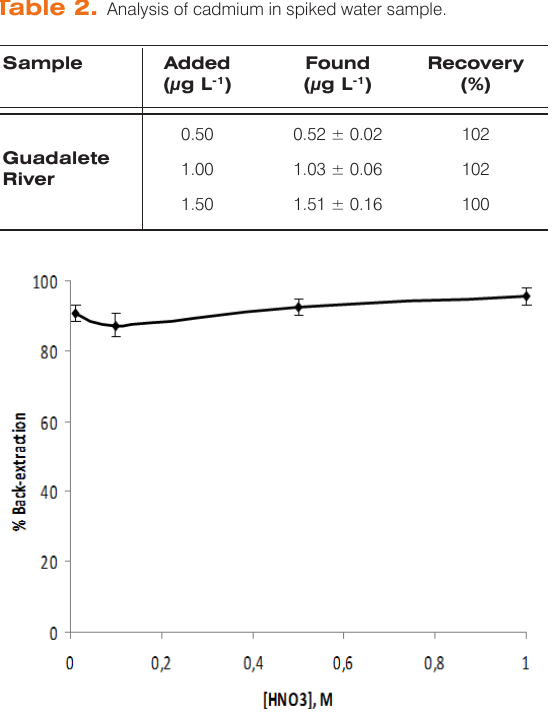
concentration in back-extraction efficiency. 3